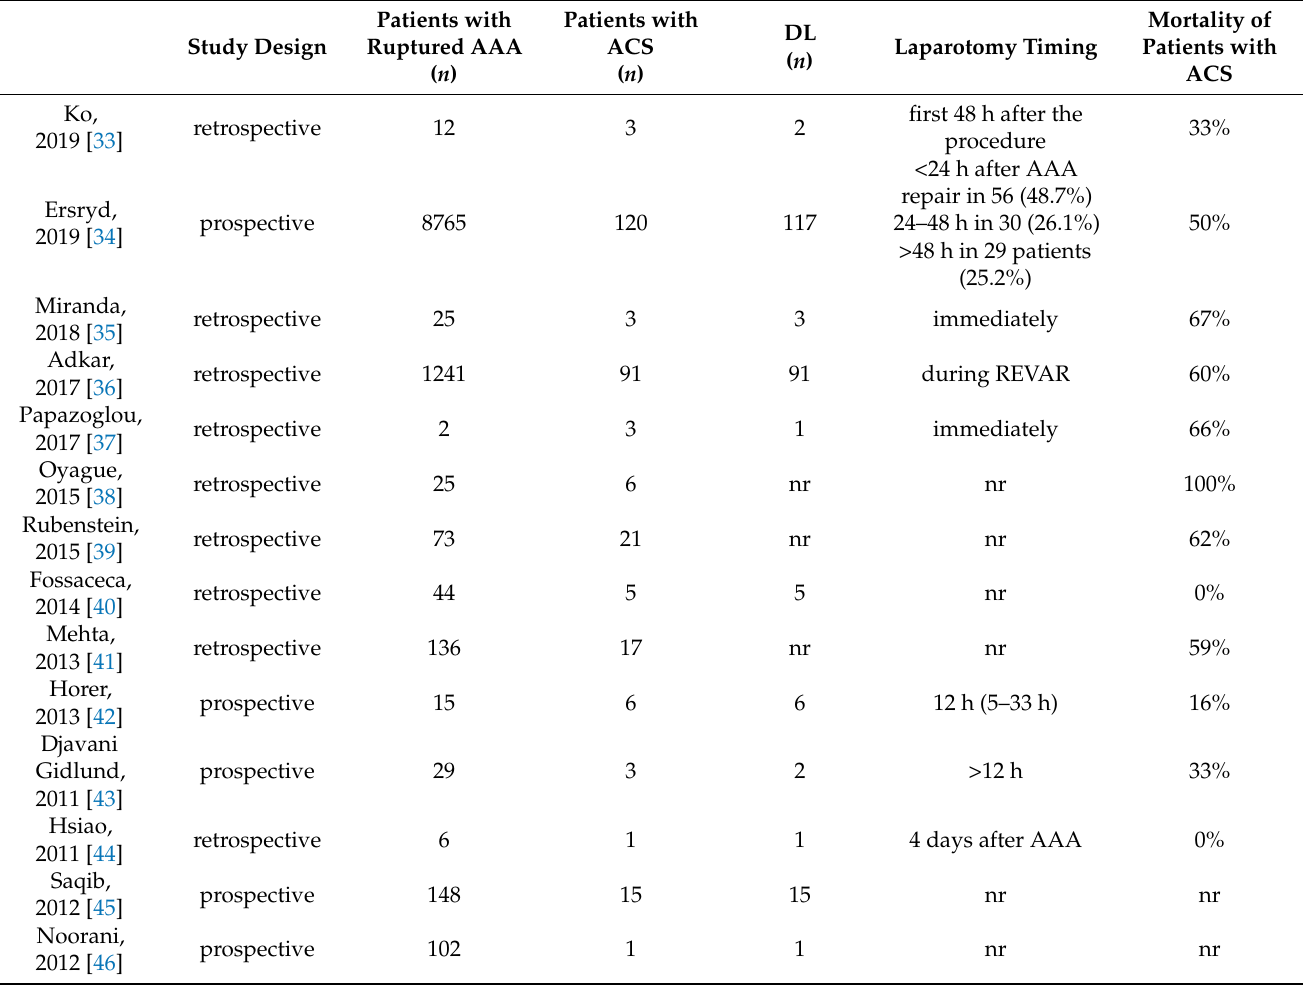
Table 2. Abdominal compartment syndrome in the context of ruptured aortic aneurysm. AAA—aortic abdominal aneurysm; ACS—abdominal compartment syndrome; DL—decompression laparotomy; nr—not reported; REVAR—endovascular aneurysm